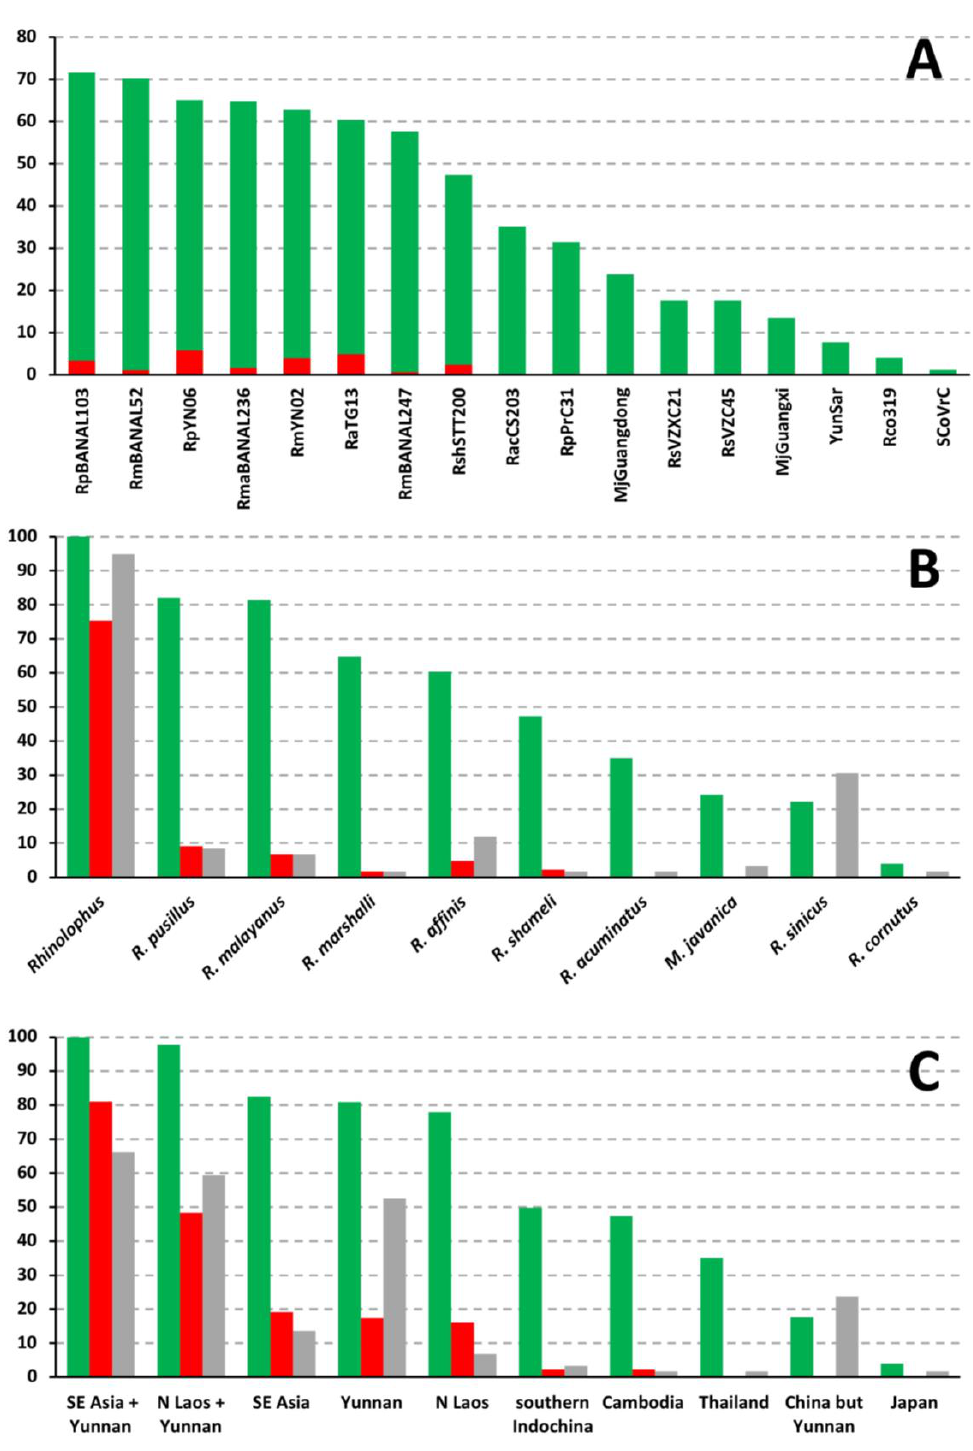
Figure 6. Percentages of whole-genome alignment including phylogenetic CGB barcodes (green histograms) shared between SARS-CoV-2 and several bat or pangolin viruses ( A ) detected in different host taxa ( B , green histograms) and geographic regions ( C , green histograms). The red histograms indicate the percentages of exclusive ancestry found in bat sarbecoviruses ( A ), host taxa ( B ) and geographic regions ( C ). To assess sampling efforts, the grey histograms show the proportions of sarbecoviruses used in our dataset for the host taxa and geographic regions of interest, respectively.